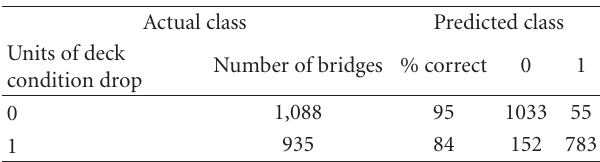
Table 6: Degree of success in deck condition deterioration prediction using the special